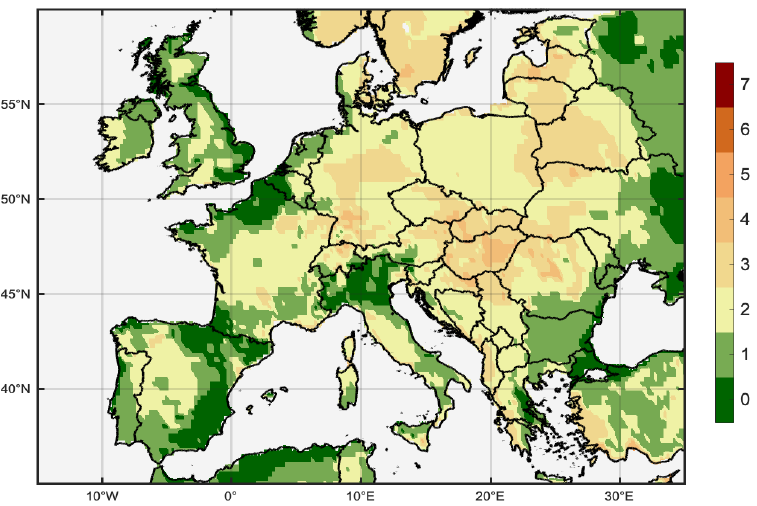
Figure 10. As in Figure 4 but considering T2m from ERA5 for 2004 – 2019.